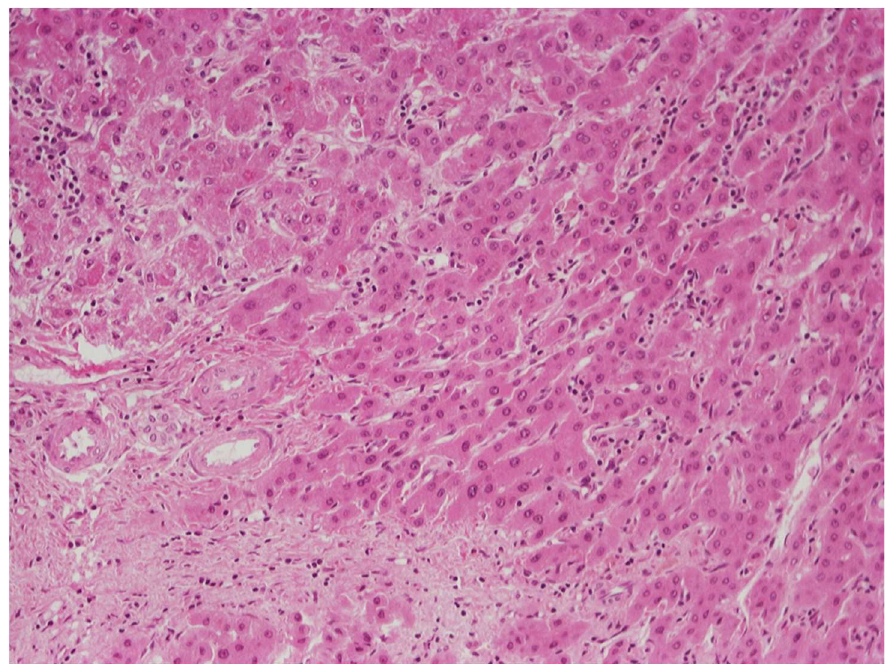
Figure 8. Well-differentiated HCC invading portal tract and fibrous septum in liver with advanced stage chronic hepatitis C. Note the absence of ductular reaction.